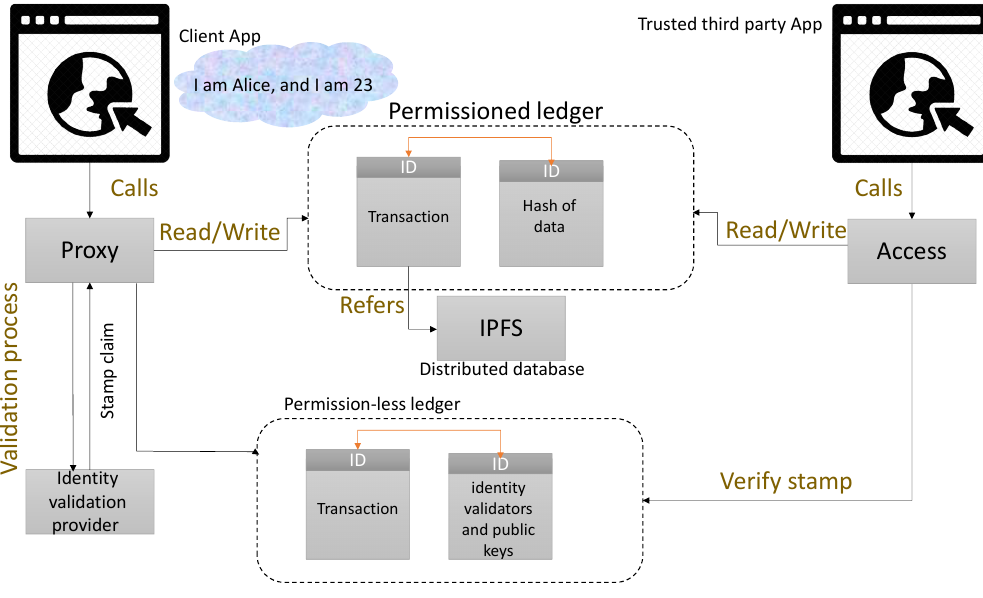
Figure 5. The new design